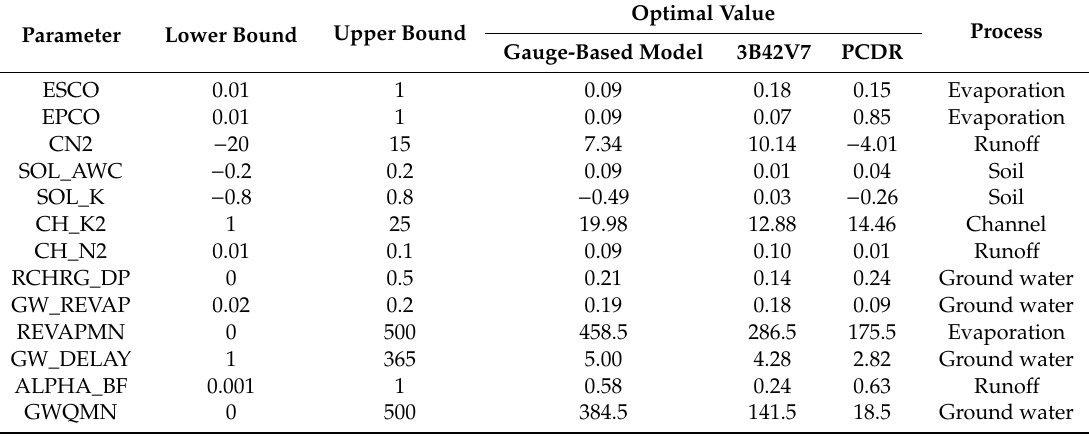
Table 2. Best fitted parameters for gauge-, 3B42V7- and PCDR-based models for monthly streamflow simulation. Parameter Lower